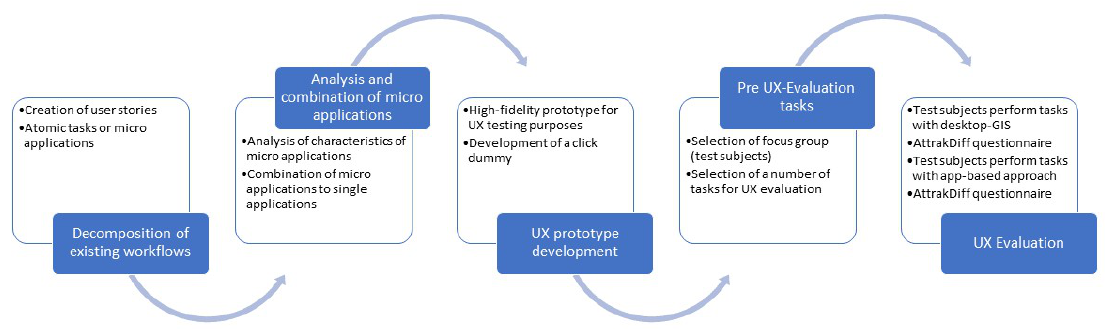
Figure 1. The overall workflow followed in the paper. The overarching methodological pillars are in the blue rectangles, whereas the finer grained methodological pieces are given in the white rectangles.